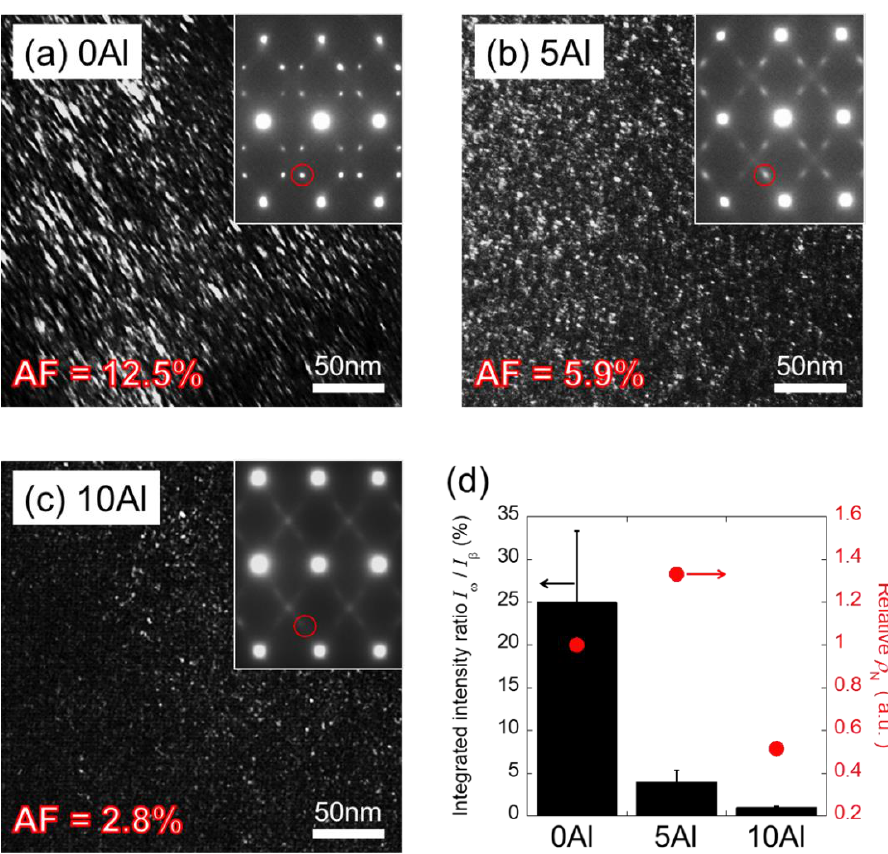
Figure 2. TEM DF images and corresponding SADPs (inserted to upper-right corner) with a [110] β zone axis of ( a ) 0Al, ( b ) 5Al, and ( c ) 10Al. Red circles in the insets of ( a – c ) indicate ω ath diffractions. ( d ) The ratio of I ω / I β of ω ath spot intensity to β spot intensity (black bars with error bars) and relative number density ( ρ N ) of ω ath -particles (red solid circles) for each alloy. Note that the relative ρ N for each alloy is normalized by taking 0Al as a standard.